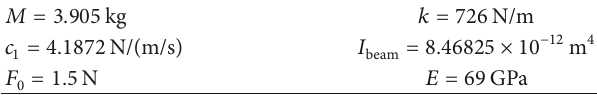
Table 2: Meaning of the parameters used in the optimization algorithm.